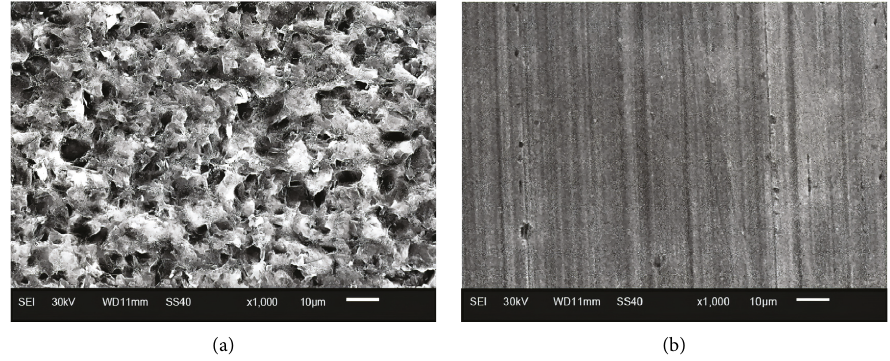
Figure 1: Surface SEM images of (a) SWS- and (b) DWS-processed mc-Si wafers.